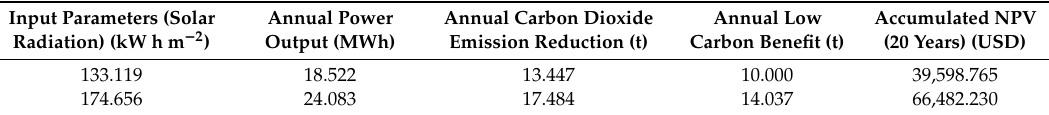
Table 15. The impact of solar radiation on the environmental and economic profitability variables in this system.